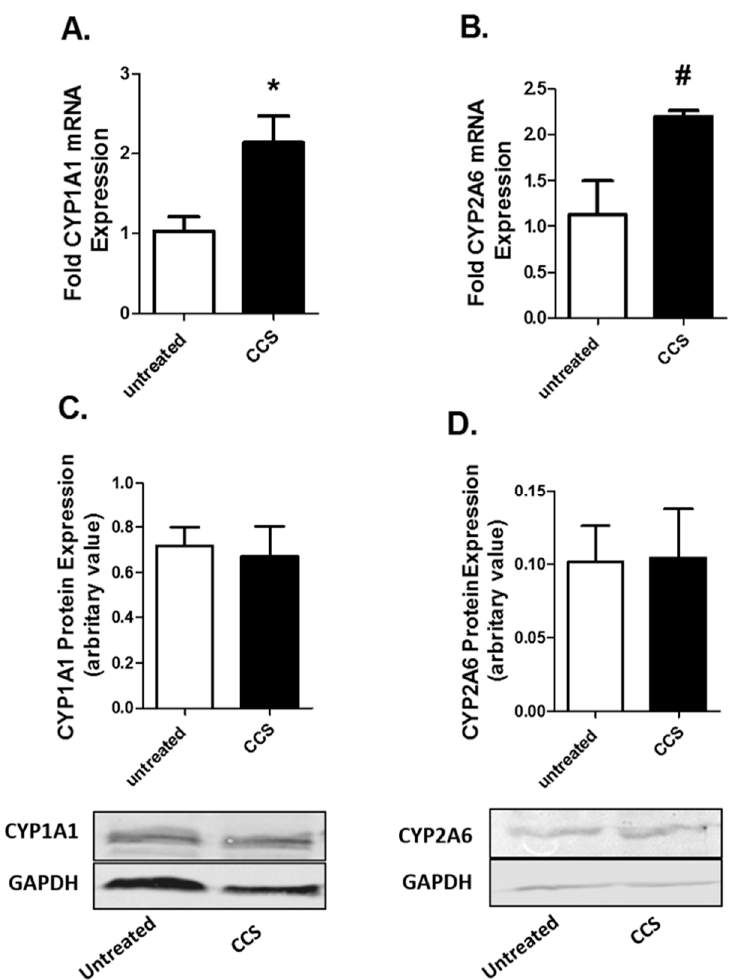
Figure 2. Caski cell culture supernatant (CCS) enhances cytochrome P450 (CYP) expression in differentiated U1 cell line. Differentiated U1 cell line was treated with 250 µL of CCS every 24 h for 4 days. Expression of CYP1A1 and CYP2A6 at the mRNA (( A ) and ( B )) and protein (( C ) and ( D )) level were monitored in the treated cells. Data were obtained from the mean of at least three independent experiments with the error bars representing the standard error of the mean. Significant difference (*) was considered at p < 0.05. * and # represent 0.1< p >0.05 respectively.